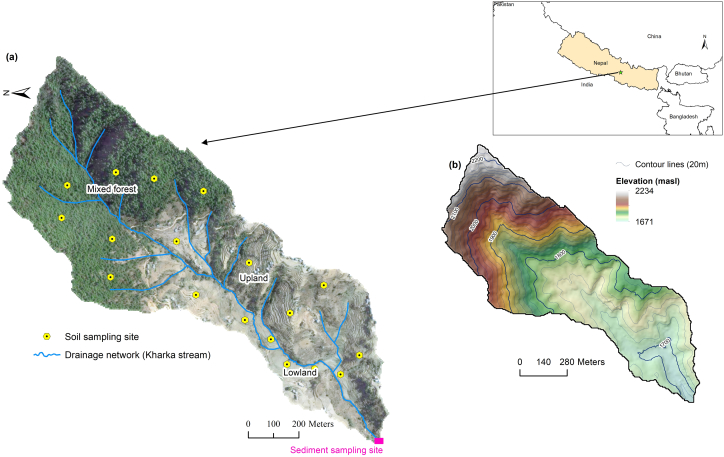
Location of the Kharka catchment in Nepal (inset) with distribution of (a) land use as well drainage network and (b) elevation.